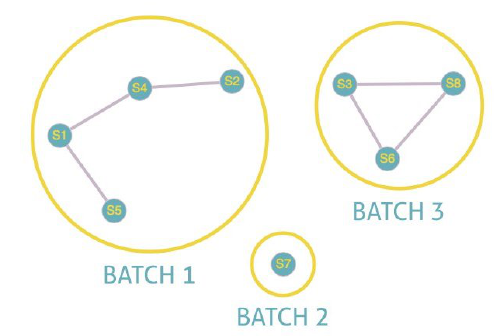
Figure 6. Unfully connected.